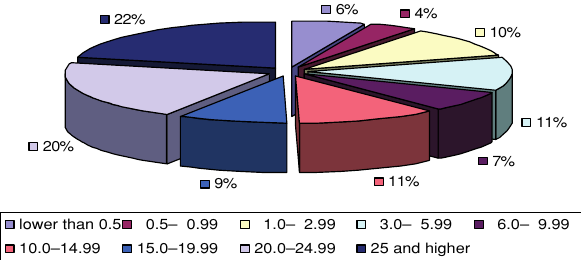
Source: Own figure based on CSO data Figure 6: Distribution of sour cherry orchards in South Transdanubia according to size F